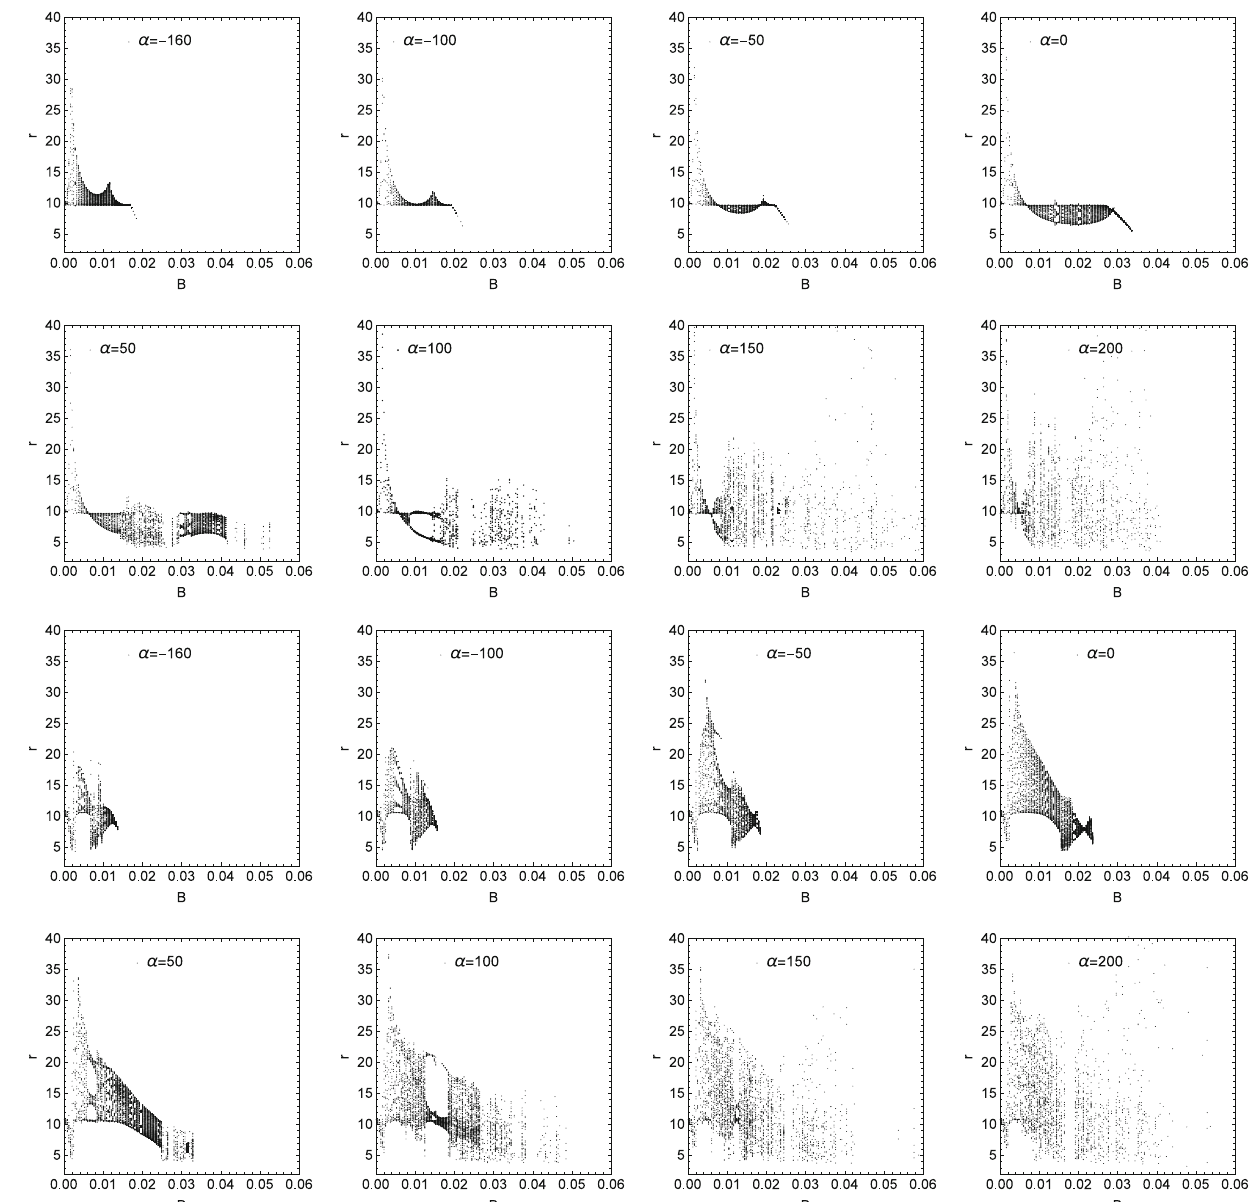
π } in the top two rows and are { r ( 0 ) = 12 ; ˙ r ( 0 ) = 0 . 1 ; θ( 0 ) = 2 π 2 the bottom two